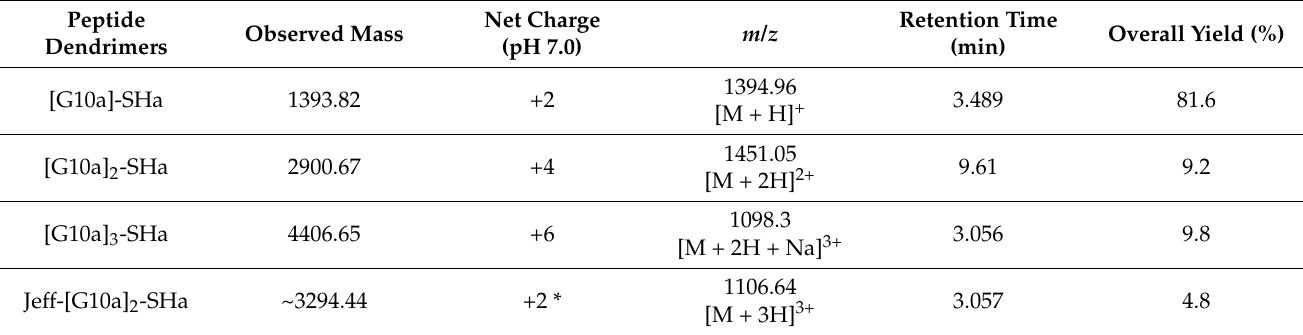
Table 2. Key physiochemical parameters of dendrimers showing molecular weights and retention time of the compounds obtained from